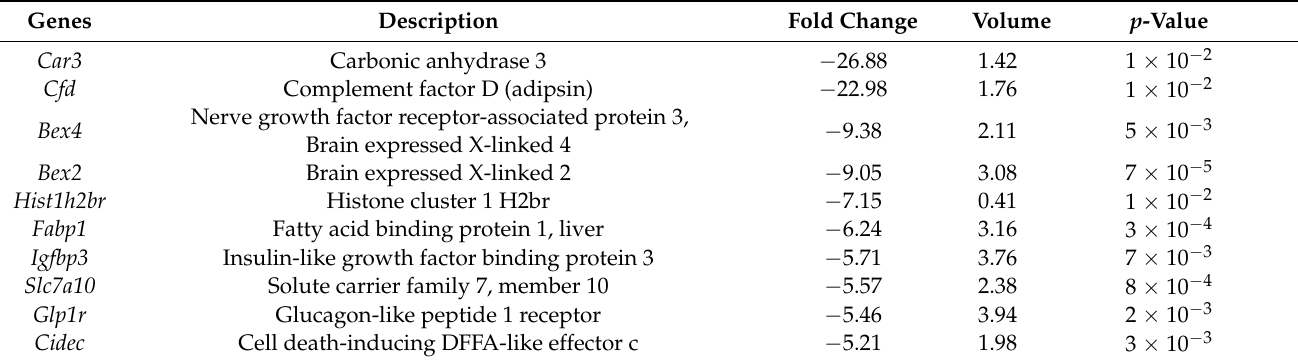
Figure 2. Distribution of differentially expressed genes by PHMG-P treatment. ( a ) The number of DEGs in the PHMG-P- treated group compared to the control group. ( b ) An overview of the DEGs is depicted by MA plot. ( c ) Heatmap based on the Euclidean distances of the DEGs. Table 2. Top 10 genes significantly upregulated by PHMG ‐ P treatment. Table 3. Top 10 genes significantly downregulated by PHMG-P